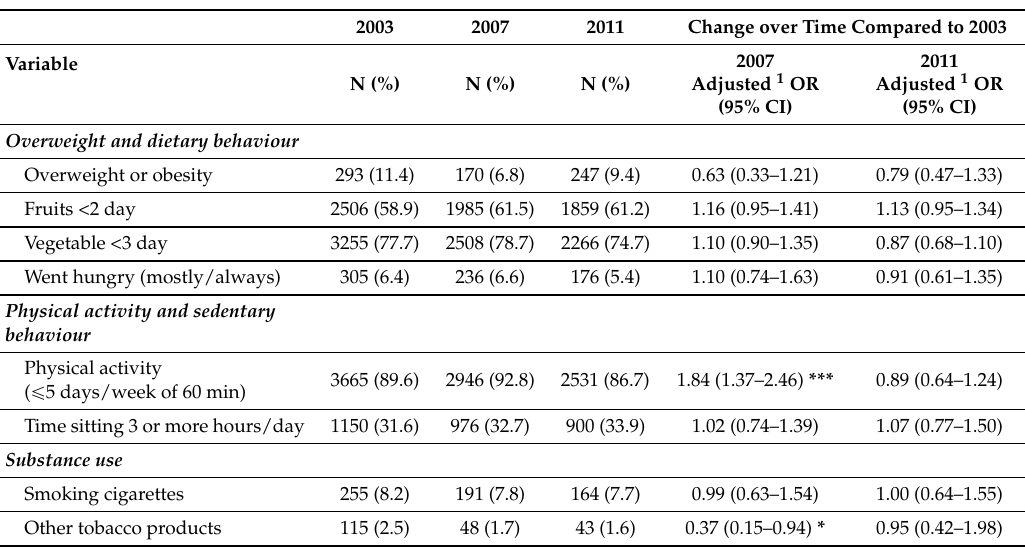
Table 3. Health risk behaviours in 2003, 2007 and 2011 among female in-school adolescents in the